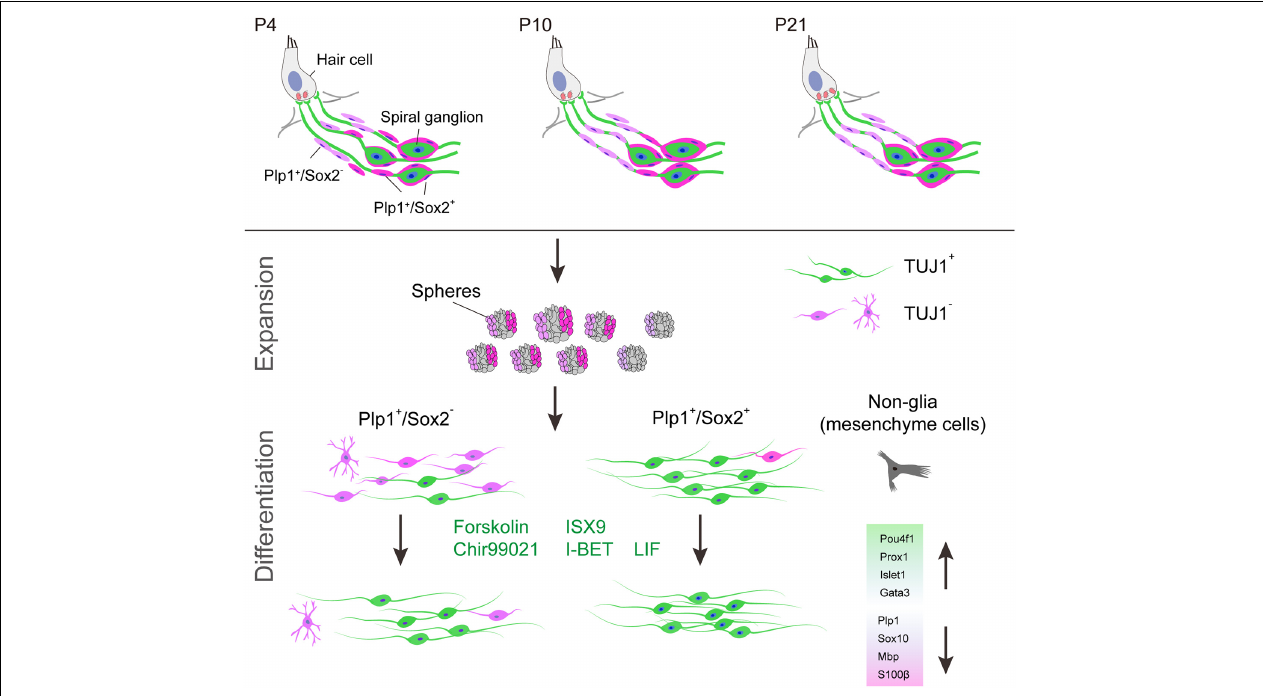
FIGURE 9 | Graphic summary of cochlear Sox2 + glial cells as potent progenitors for spiral ganglion neuron reprogramming induced by small molecules. Sox2 + cells are a subpopulation of Plp1 + cochlear glial cells. Although both Sox2 + and Sox2 − glial cells can form neurospheres, Plp1 + /Sox2 + spheres are more neurogenic compared to Plp1 + /Sox2 − spheres. Efficiency and maturity of the induced neurons can be further improved by a small molecule cocktail.